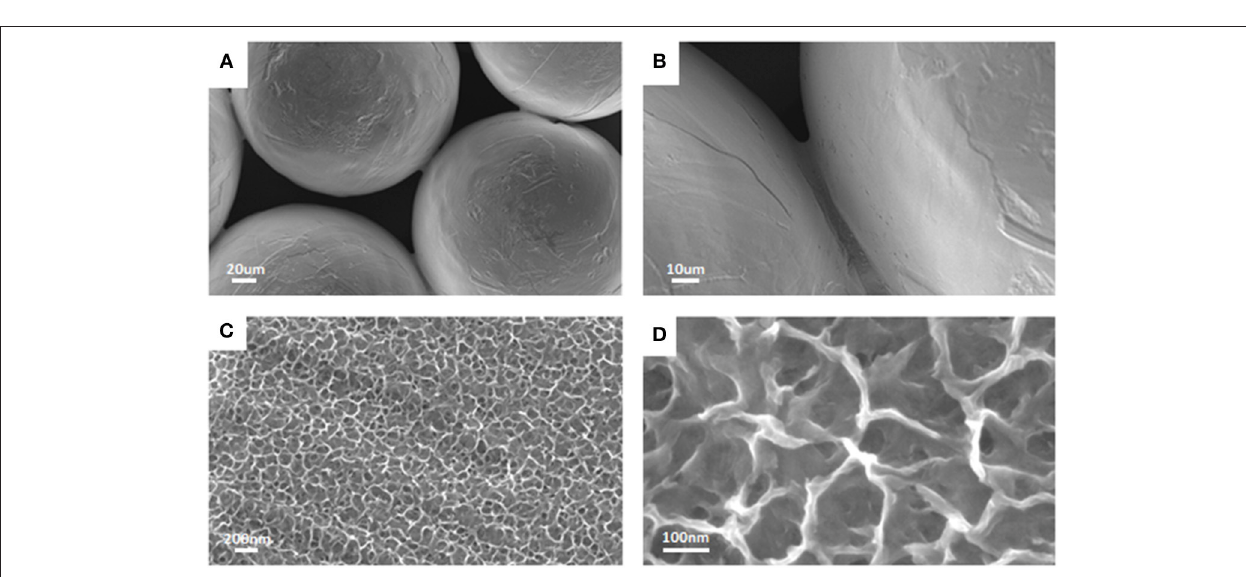
FIGURE 5 | FESEM observations of treated sintered titanium micro-spheres. The original spherical shape was maintained after the chemical treatment (A,B) that was effective in introducing the nanotextured layer (C,D) as previously observed for cup and